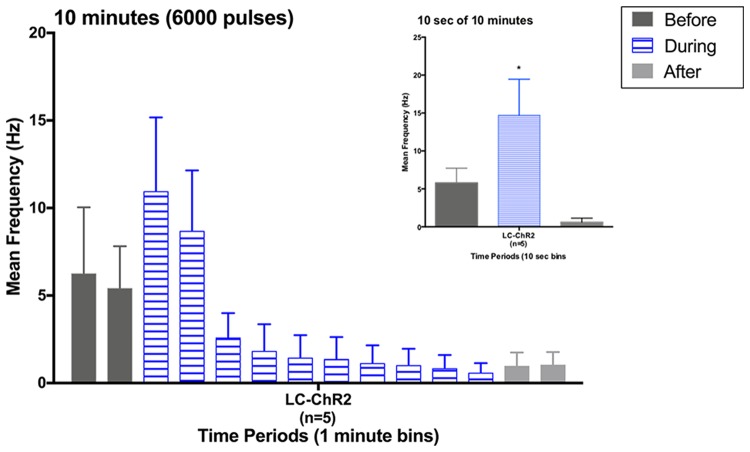
Histogram for LC units during the 10 min light activation protocol in 1-min bins. Inset: histogram for the first 10 s of light activation in the 10 min period. Note similarity to previous 10 s light data. *p < 0.05.